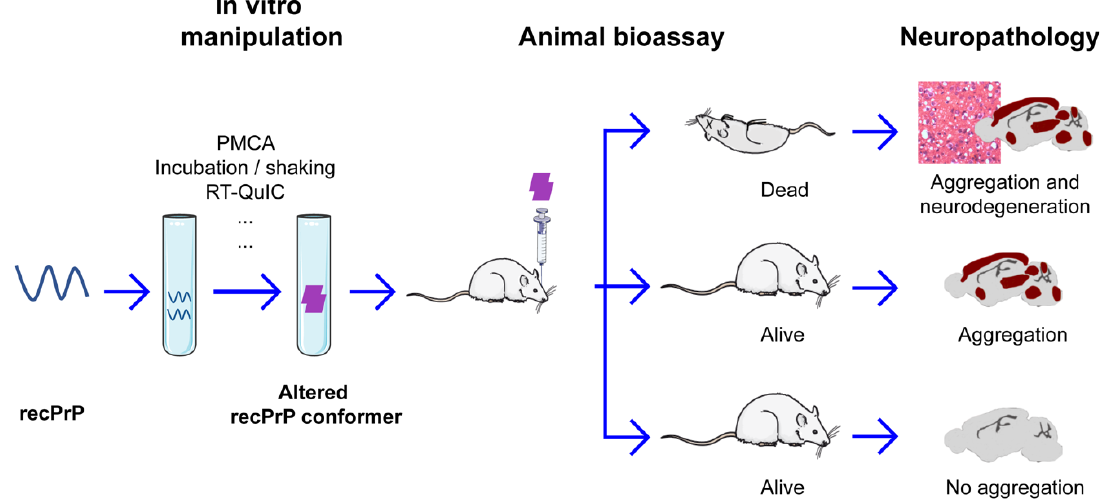
Figure 1. Overview of recombinant prion preparation and animal